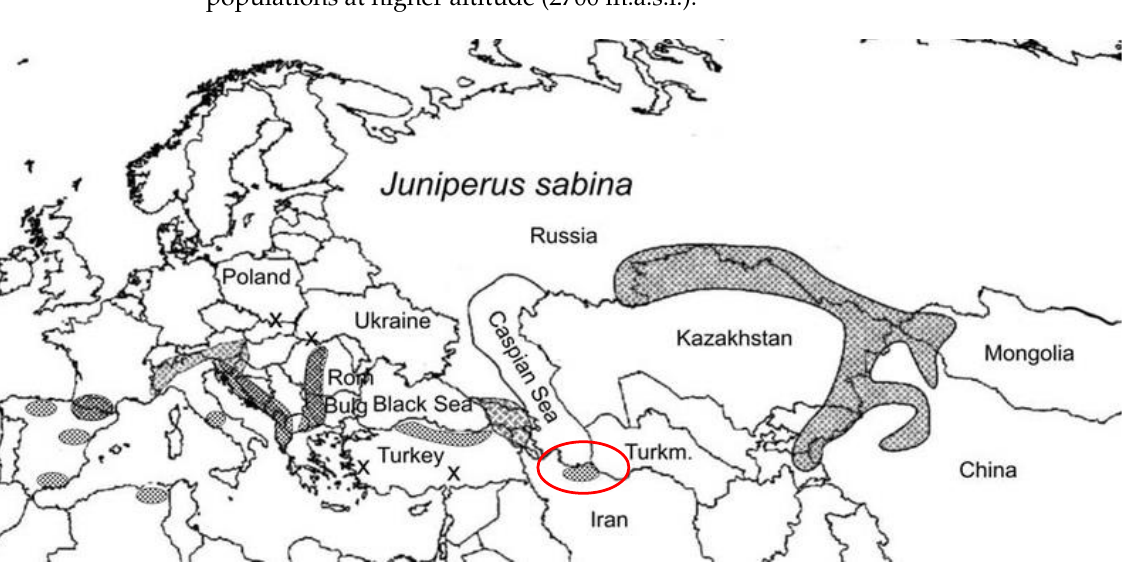
Figure 1. Worldwide distribution of different populations of Juniperus sabina , in gray [27] ; sampling area of collected stem cuttings is in red circle (Northern Iran).